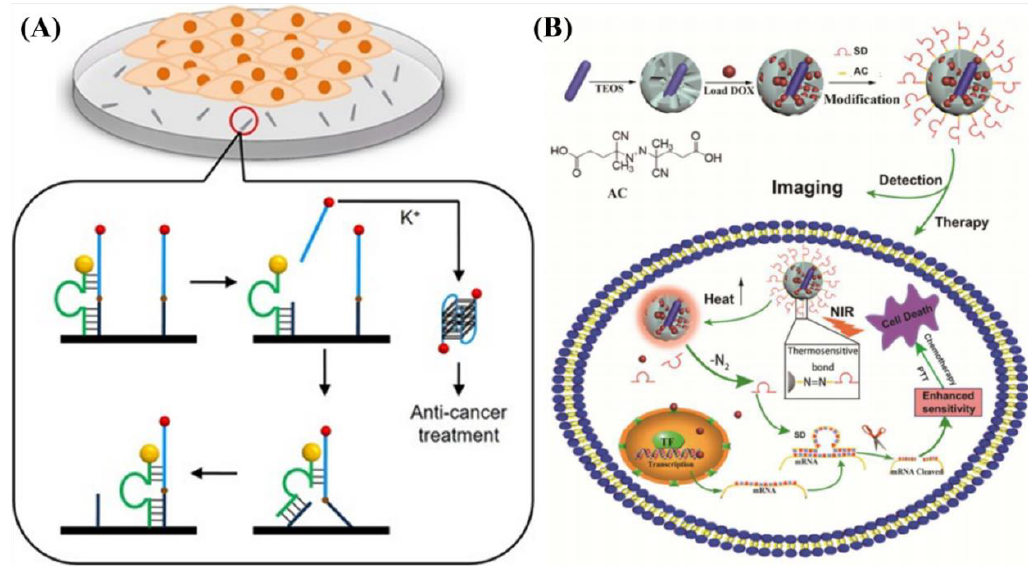
Figure 8. Representative examples for in vivo cancer therapy based on RNA-cleaving DNAzymes. ( A ) A working mechanism of a DNA walker-mediated platform for inhibiting cancer cell growth. Reprinted with permission from reference [82]. Copyright 2016 Wiley-VCH. ( B ) Assembly of the DNAzyme-based nanosystem for near-infrared (NIR)-light-activated combinational cancer therapy. Reprinted with permission from reference [85]. Copyright 2018 The Royal Society of Chemistry.